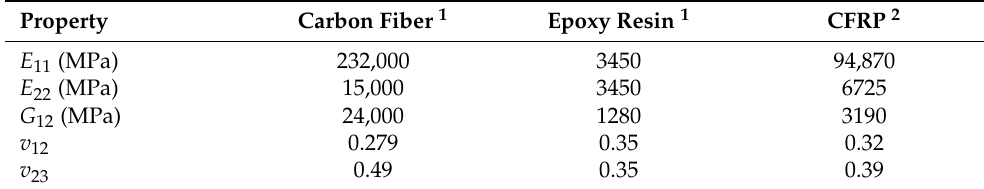
Table 2. Summary of elastic properties of carbon fiber, epoxy resin and